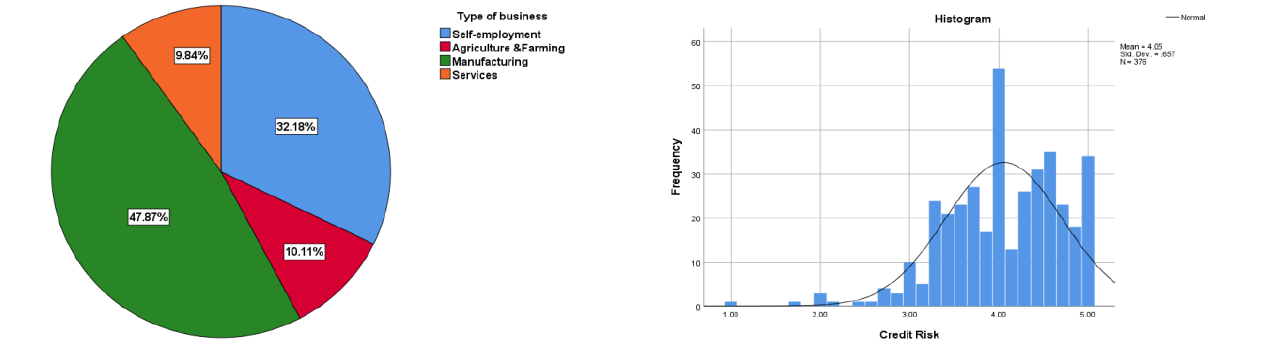
Figure 4: Type of Business Involved by the Respondents of the Sample. Figure 5: Histogram of Credit Risk